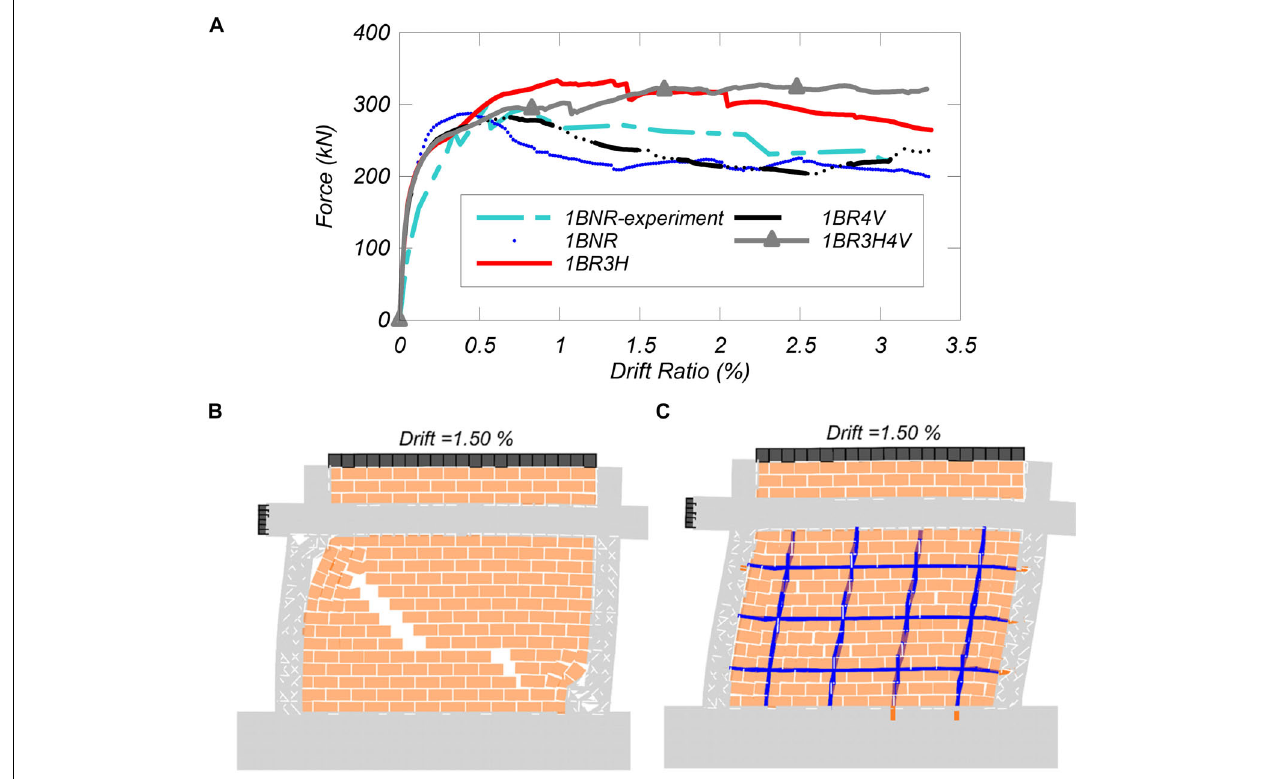
FIGURE 13 | Response of the one-bay retrofitted solutions tested: (A) lateral force vs. drift ratio curves of the one-bay frame, (B) deformed shapes at 1.5 percent drift ratio for the one-bay non-retrofitted example, and (C) deformed shape of one-bay example retrofitted with